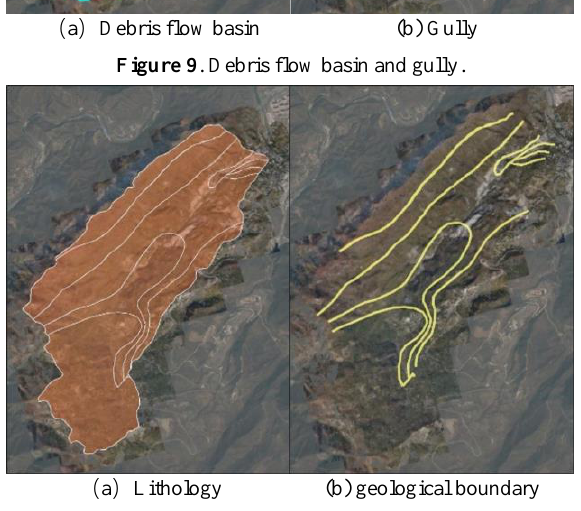
Figure 9 . Debris flow basin and gully.